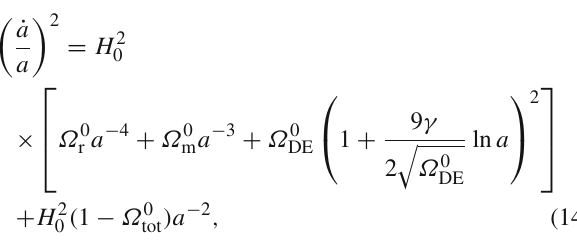
at early epoch is higher than that of in Λ CDM while for the late time this contribution is less than Λ CDM demonstrating an almost oscillatory